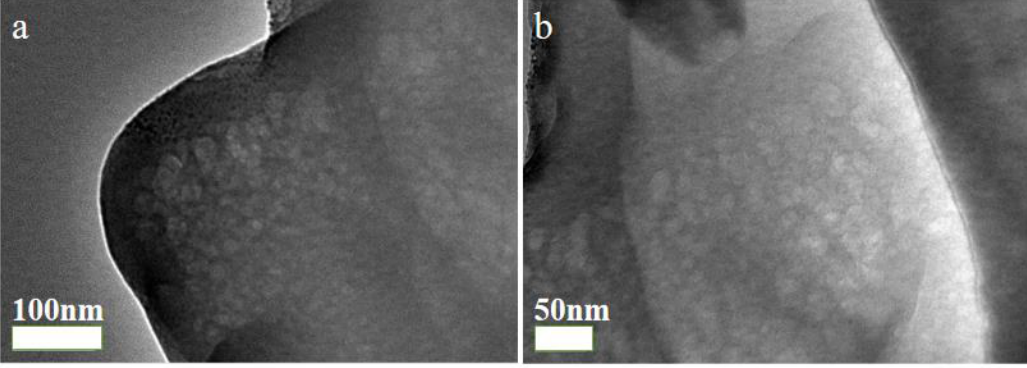
Figure 2. ( a ) TEM images of BTA and ( b ) BTA after magnification.